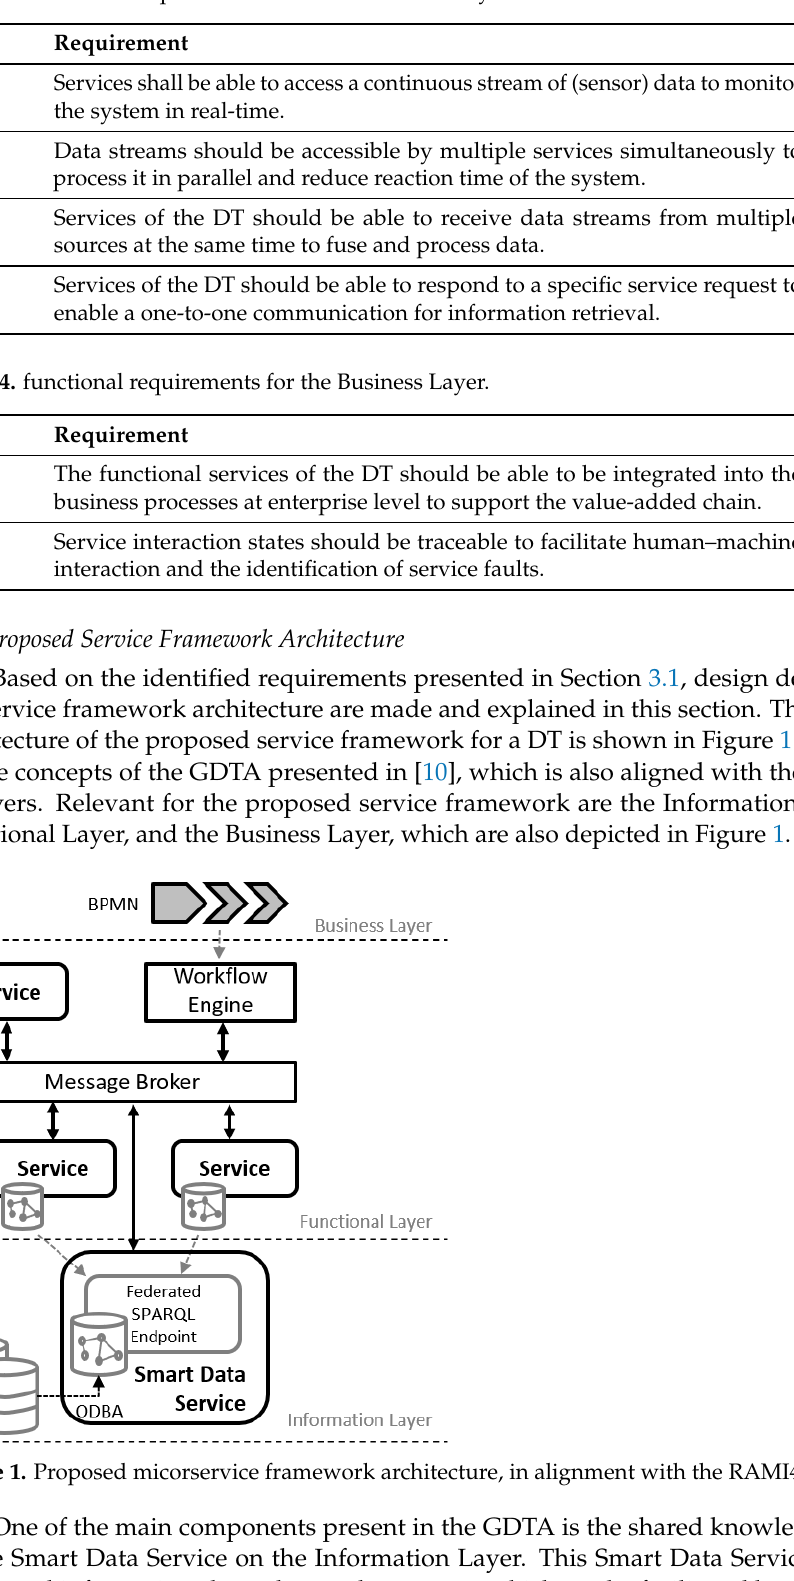
Table 3. Functional requirements for the Functional Layer.